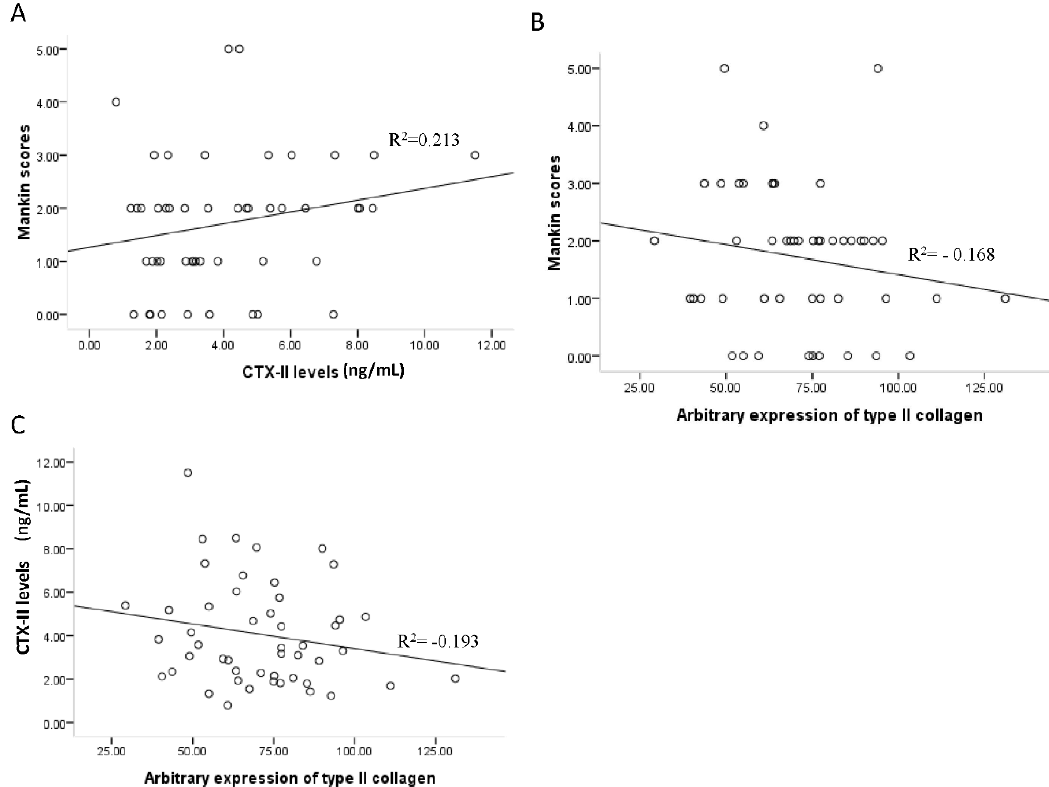
Figure 5. Correlation between Mankin scores, type II collagen expression, and serum CTX ‐ II levels. Pearson’s correlation coefficient was calculated for each pair of parameters: ( A ) serum CTX ‐ II levels and modified Mankin scores, R 2 = 0.213; ( B ) type II collagen expression and modified Mankin scores, R 2 = − 0.168; and ( C ) type II collagen expression and serum CTX ‐ II levels, R 2 = − 0.193. Each point on the graph represented a single mouse.